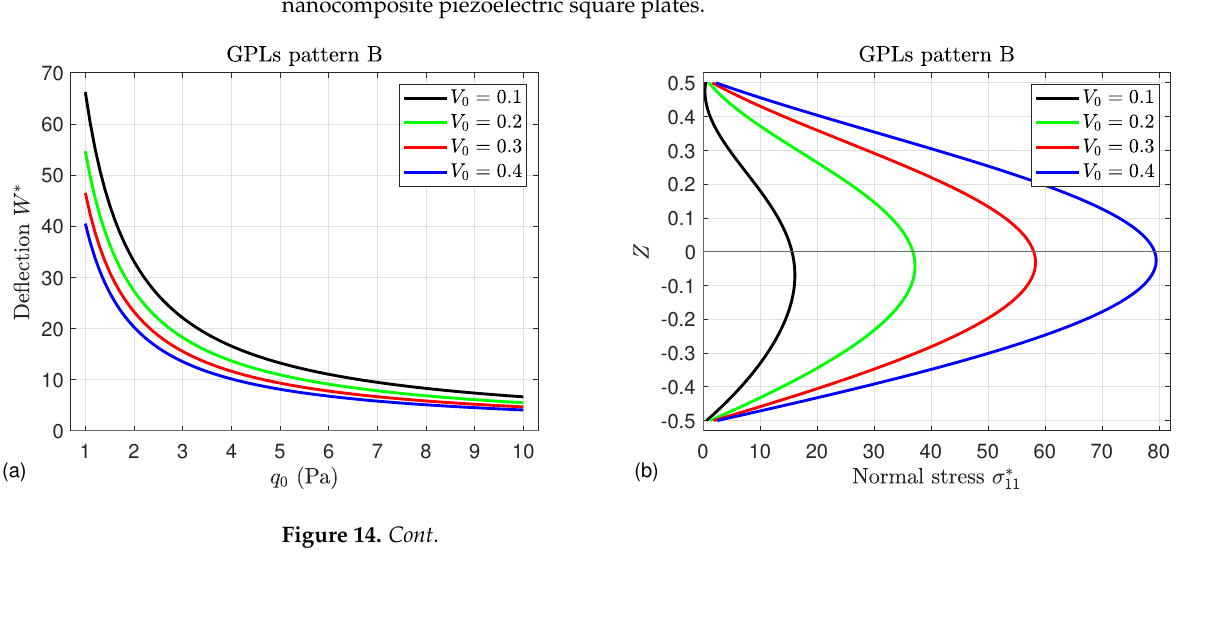
of FG porous 12